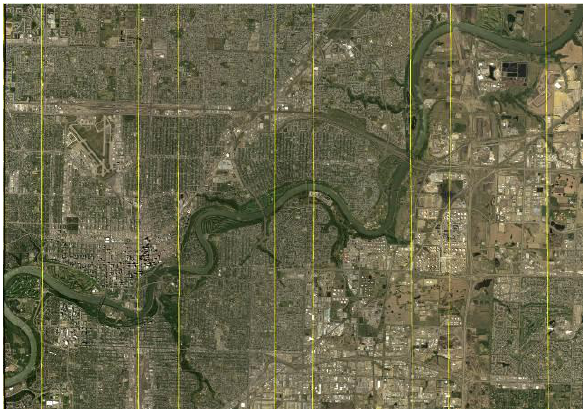
Figure 16. Four flight lines grouped into a seamless mosaic, the yellow lines are the footprints of the images (ADS100